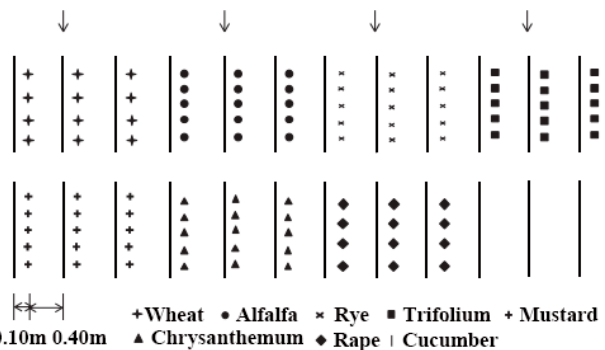
Figure 1. The different intercropping systems and the cucumber monocultured system in the greenhouse experiment.